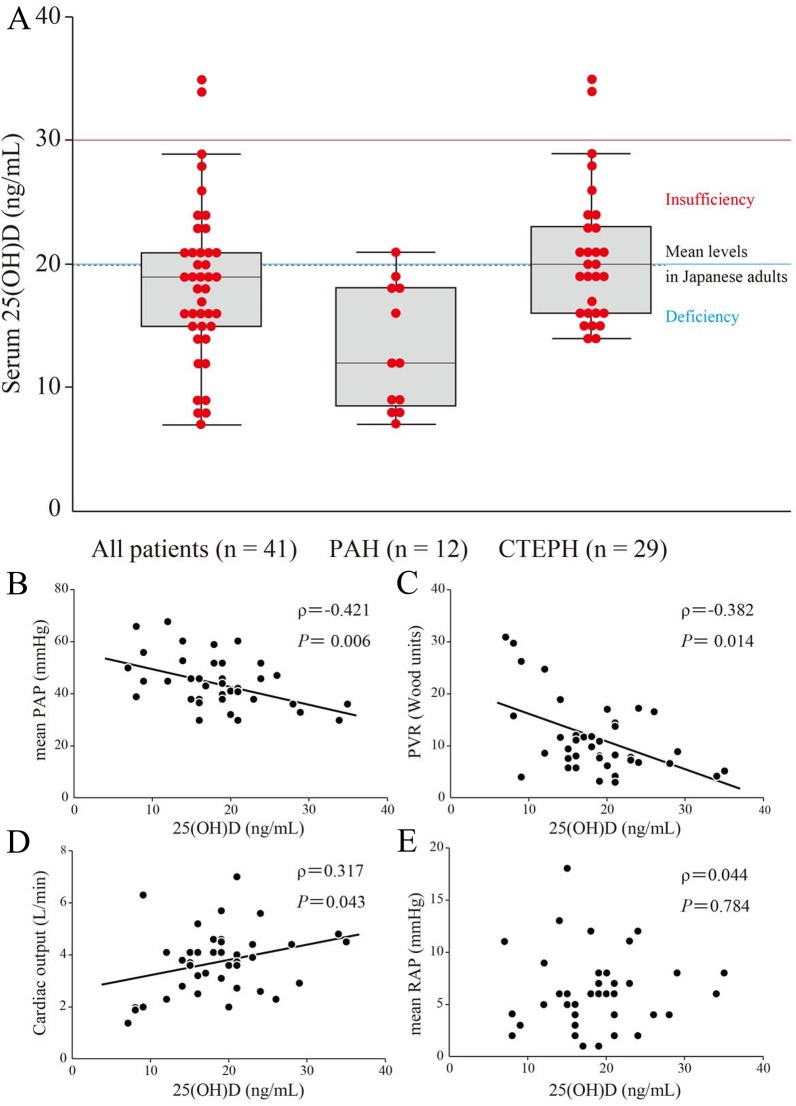
Relationship between serum 25-hydroxyvitamin D (25(OH)D) levels and hemodynamic parameters in patients with pulmonary hypertension (PH).Serum 25(OH)D levels and hemodynamic parameters were measured in 41 patients with PH, consisting of 12 patients with idiopathic or heritable pulmonary arterial hypertension (PAH) and 29 patients with chronic thromboembolic pulmonary hypertension (CTEPH). (A) Serum 25(OH)D levels in each PH classification. Serum 25(OH)D levels are shown as box plots, with bars denoting median values, boxes denoting interquartile ranges, and whiskers denoting ranges, excluding statistical outliers (●; >1.5 box lengths from either the 25th or 75th percentiles). Serum 25(OH)D levels of insufficiency (red line), deficiency (blue line), and the mean levels in Japanese adults (black broken line) are shown. (B)-(E) Correlations in 41 patients with PH were analyzed between 25(OH)D levels and mean pulmonary arterial pressure (PAP) (B), pulmonary vascular resistance (PVR) (C), cardiac output (D), and mean right atrial pressure (RAP) (E), respectively.